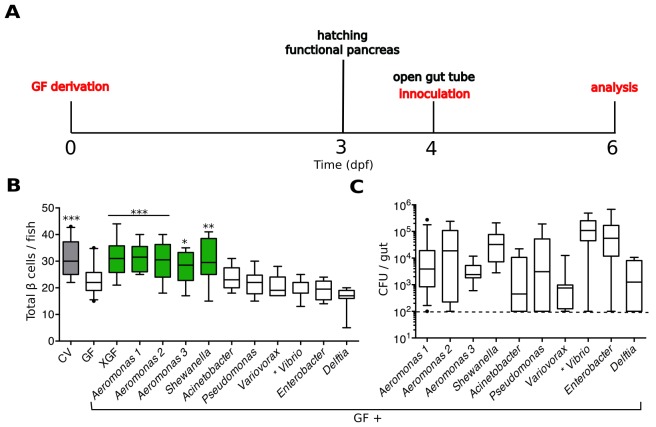
Specific bacterial members of the zebrafish microbiota are sufficient to rescue normal expansion of the GF β cell mass.(A) Experimental timeline for all subsequent zebrafish experiments, unless stated otherwise.Experimental manipulations are denoted by red text. Important zebrafish developmental events are denoted by black text. (B) Quantification of β cells in CV, GF and GF larvae treated at 4 dpf with either non-sterile tank water (XGF) or mono-associated with a specific bacterial strain. Bacterial mono-associations are labeled by genus. Different Aeromonas sp are labeled with a number (1, 2 or 3). *p<0.05, **p<0.01, ***p<0.001: Denotes treatment that is significantly different than GF by Tukey analysis. Additionally, here and in all subsequent figures, significant data sets (p<0.05 when compared to GF) are also highlighted as green box plots. (C) Bacterial isolates of the zebrafish gut and related strains are capable of forming mono-associations with larvae from 4 to 6 dpf. Quantification of the colony forming units (CFUs) per gut for each bacterial strain, assayed after 48-hr exposure to GF larvae. Dashed line denotes the limit of detection.DOI:
http://dx.doi.org/10.7554/eLife.20145.00610.7554/eLife.20145.007Figure 2—source data 1.Quantifications and statistical analysis of larval β cells corresponding to Figure 2B.Exact values of N, mean, median, SD, and SEM are reported in the source data file and are highlighted in yellow, magenta, blue, green, and cyan, respectively.